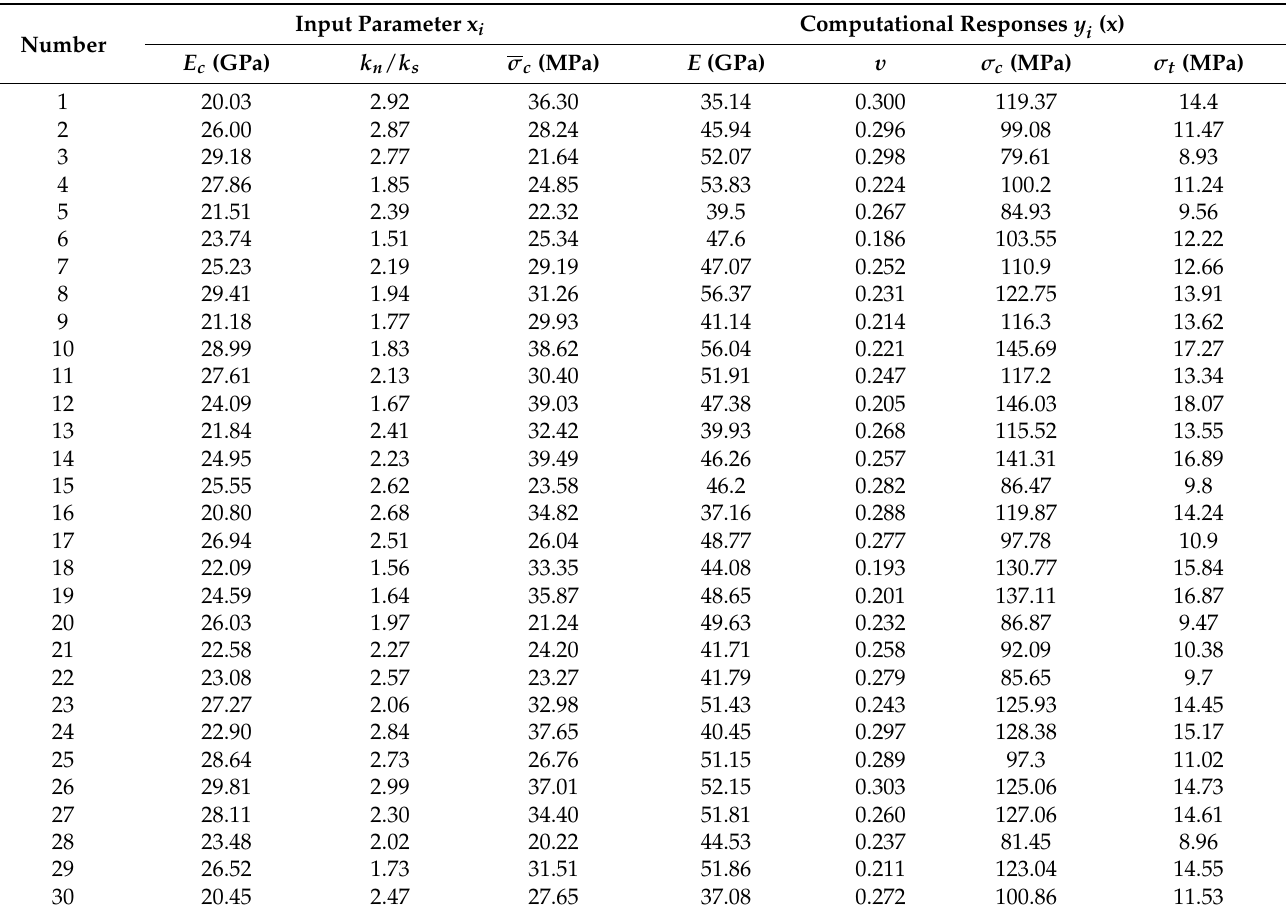
Table 3. Samples by LHD method and corresponding computational responses.